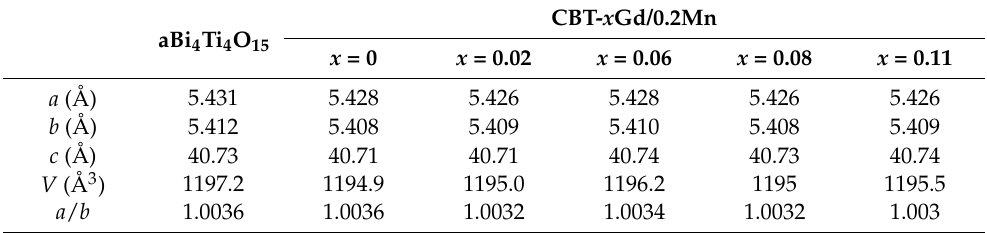
Figure 1. Rietveld analysis of XRD patterns of the CBT − x Gd/0.2Mn ceramics measured at room temperature. Table 1. Lattice parameters of the CBT- x Gd/0.2Mn